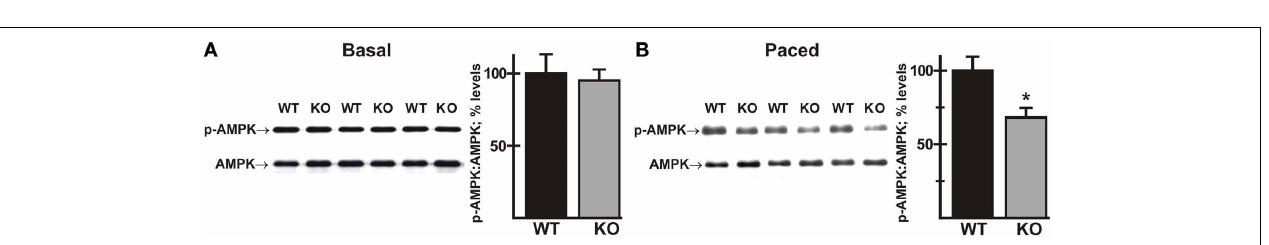
levels of: (A) total AMPK and phosphorylated AMPK (Thr172) under basal conditions; and (B) total AMPK and phosphorylated AMPK (Thr172) during pacing at 550bpm. Results show representative immunoblot and percent relative levels (normalized to total AMPK levels) of phosphorylated AMPK. Values shown are means ± SE, n = at least 8 for each genotype and pacing condition. ∗ p < 0 . 05 vs.